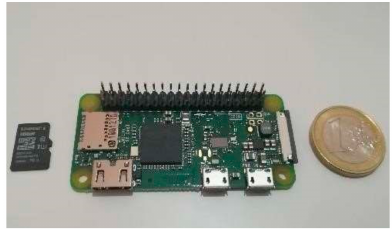
Figure 8. Raspberry Pi Zero